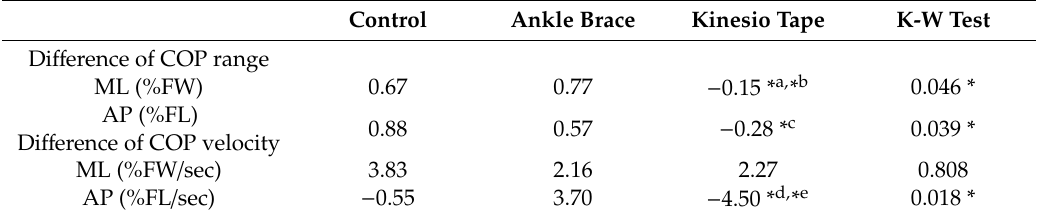
Table 3. Kruskal–Wallis and post hoc test results for fatigue-induced change in median values of the COP variables in single-leg lateral drop landing tasks performed by three groups. Control Ankle Brace Kinesio Tape K-W Test Di ff erence of COP range ML (%FW) 0.67